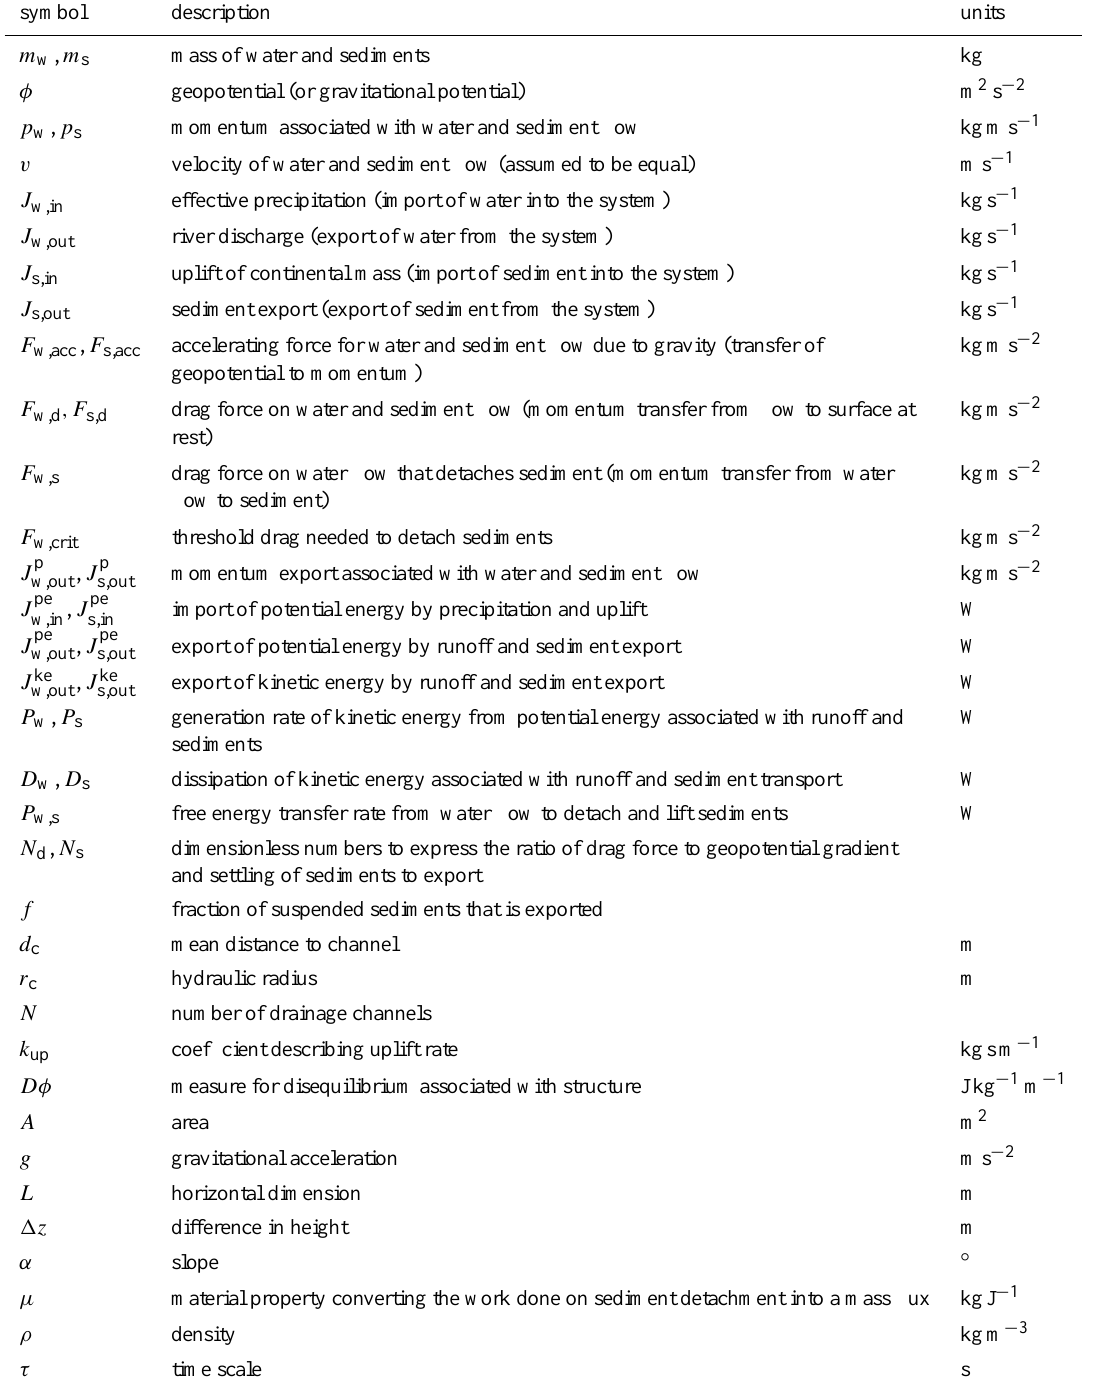
Table 3. Overview of the parameter and variable names used in the models. The variables follow a terminology in which all fluxes of a property are described by J , the generation of free energy of some form from another form is described by P , the dissipation of free energy into heat by D , and forces by F . The subscript index refers to the substance (w: water, s: sediment), while the superscript refers to the type of flux (no superscript: mass; p : momentum; ke: kinetic energy; pe: potential